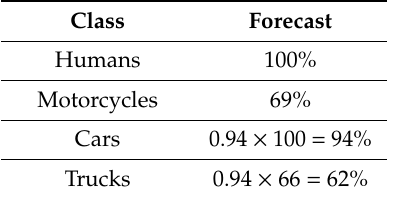
Table 12. Cases 6 and then 5 prediction